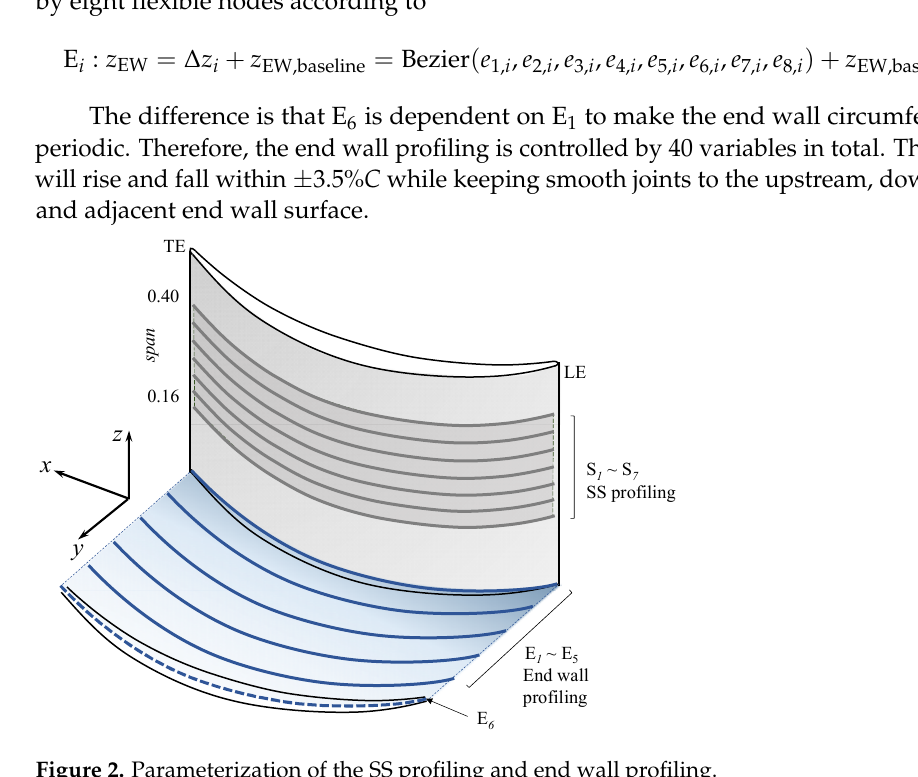
Figure 3. The geometry parameters of the baseline cascade. 2.3. Baseline Compressor Cascade and the CFD Method This study uses a typical high-load low-speed linear compressor cascade, as shown in Figure 3. The baseline blade geometry uses multiple circle arcs with a designed flow turning angle of 51° and diffusion factor ( DF ) of 0.5. Its solidity exceeds 2.0. Zhang [3] conducted a detailed experimental and numerical study on this cascade and has con- firmed a significant three-dimensional corner separation occurring in the end wall region of this cascade. According to previous research [32], the cascade operates at the design point when the incidence ( i ) equals −1°, and the corner stall occurs when i exceeds +7°. Using linear cascade instead of an actual compressor ensures that the investigation of flow control will not be influenced by twisted blade sections, leakage flow, centrifugal force, and inlet boundary layer skew, but rather the inlet boundary layer and the secondary flow. So, only the most common features of a high-load compressor are considered, and the results will be universal. The CFD results of the above cascade presented in this paper are computed using ANSYS CFX. Only a half-span of the single-passage cascade has been simulated with a free-slip boundary condition at the mid-span position to reduce the simulation time. The mesh is generated using NUMECA AutoGrid5. Figure 4 provides an overview of the com- putational domain. The inlet and outlet passages both use long extended “H” blocks. The former extends to 1.2 Ca upstream of the LE, which is the location where experimental